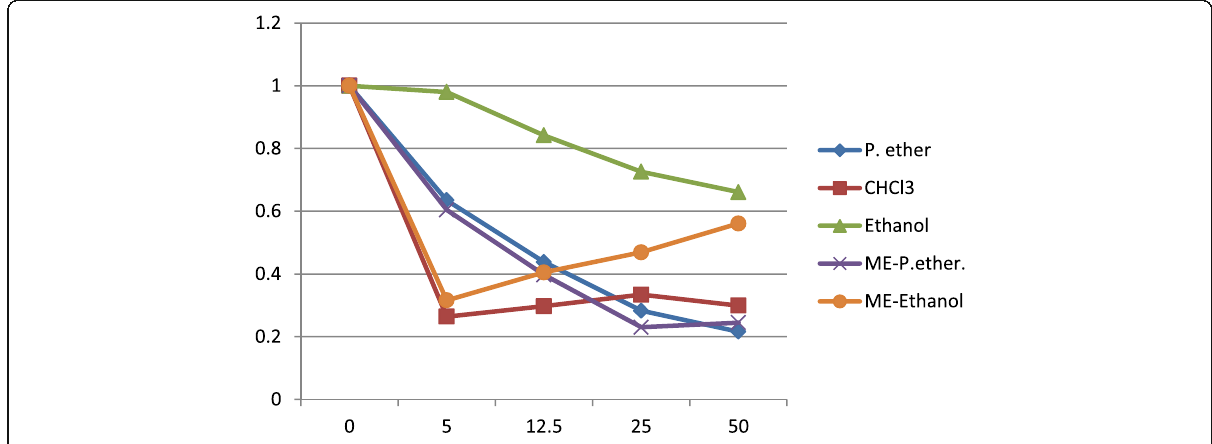
Fig. 4 Cytotoxicity of Thevetia peruviana extracts and ME formulations on liver carcinoma cell line